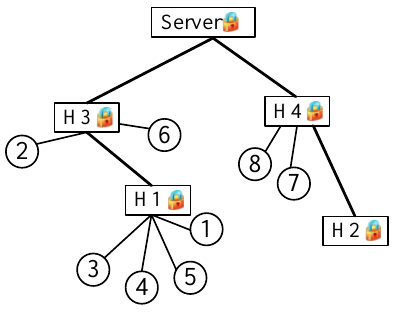
Figure 1. Network